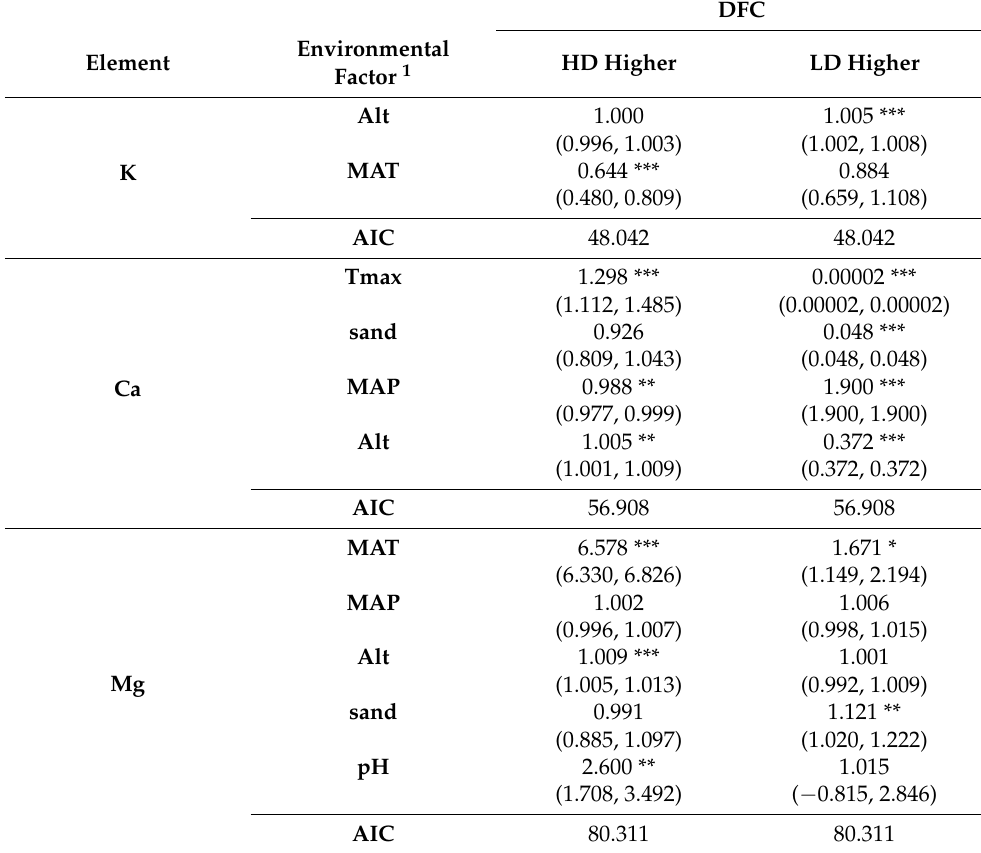
Table 5. Results of multinomial logistic regression for Differences in Foliar Concentrations (DFC) of potassium, calcium and magnesium and corresponding model AIC. Odds ratios are reported for each environmental factor while the confidence intervals are given in the brackets (* p < 0.1, ** p < 0.05, *** p < 0.01).